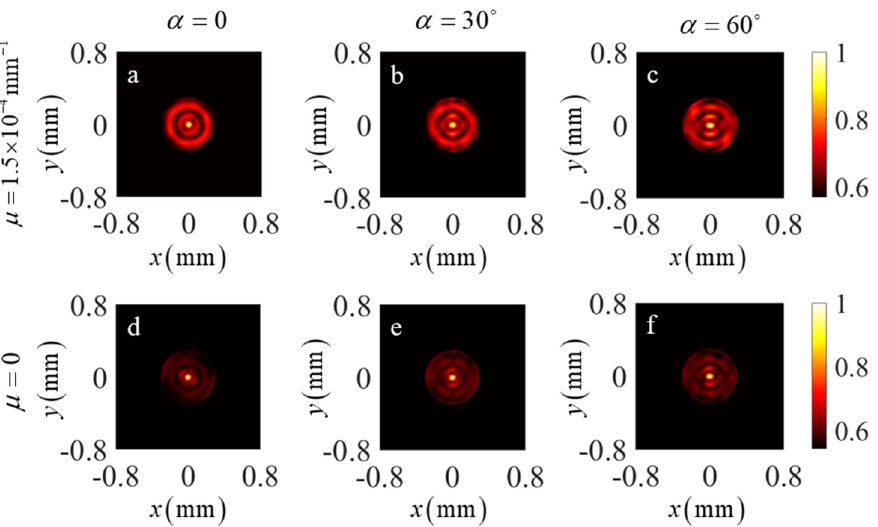
Figure 11. The experimental results for the spatial degree of coherence | γ ( ρ , − ρ ) | 2 in the focal plane of the generated TLGSM beam with ( a – c ) the twist factor µ = 1.5 × 10 − 4 mm − 1 and ( d – f ) µ = 0. The TLGSM beam is obstructed by a sector-shaped opaque obstacle with center angle ( a , d ) α = 0, ( b , e ) α = π /6, and ( c , f ) α = π/3 .